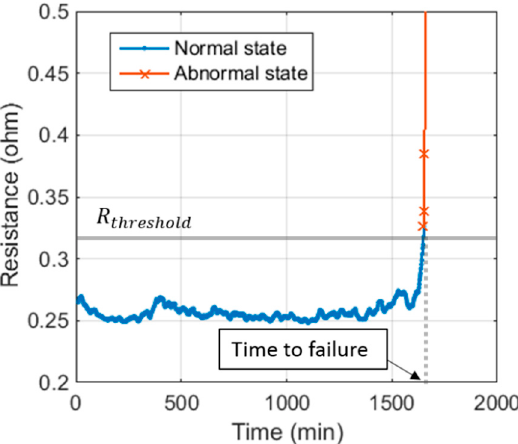
Figure 10. Direct current (DC) resistance measurement during corrosion testing (Test #1).